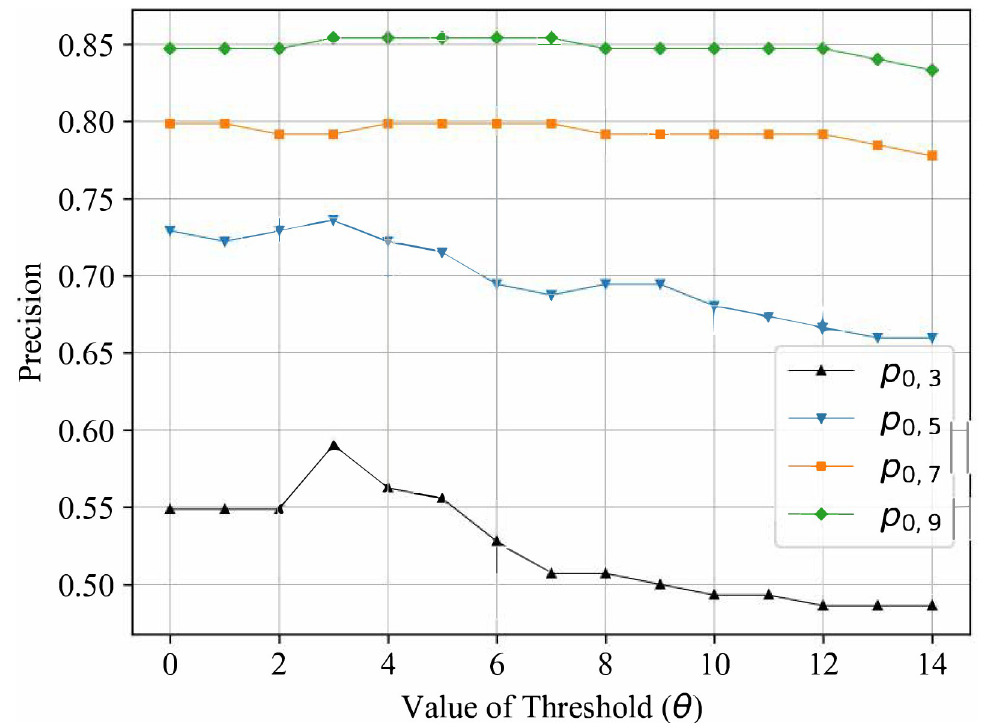
Fig 3. The precision within each error range versus θ